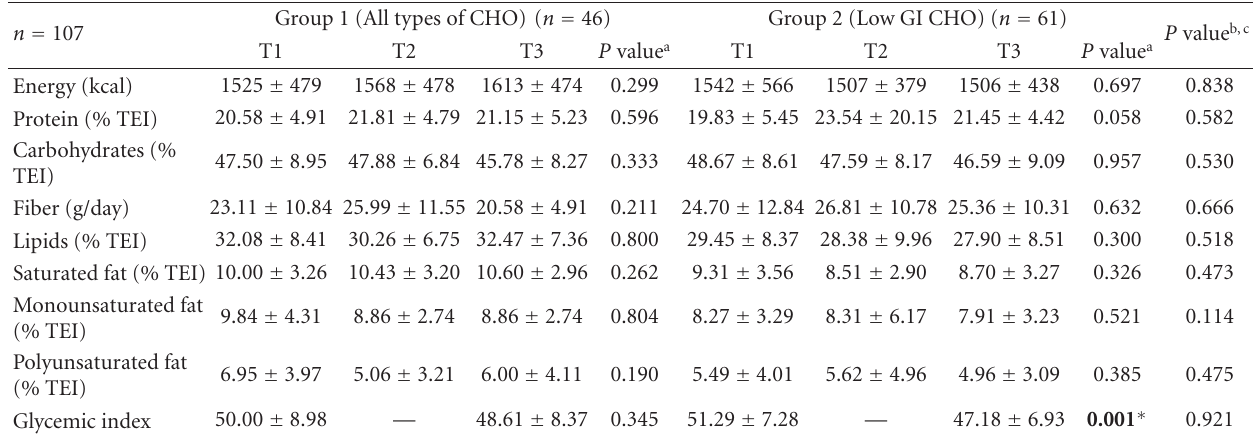
Table 5: Dietary intake throughout the intervention in both study